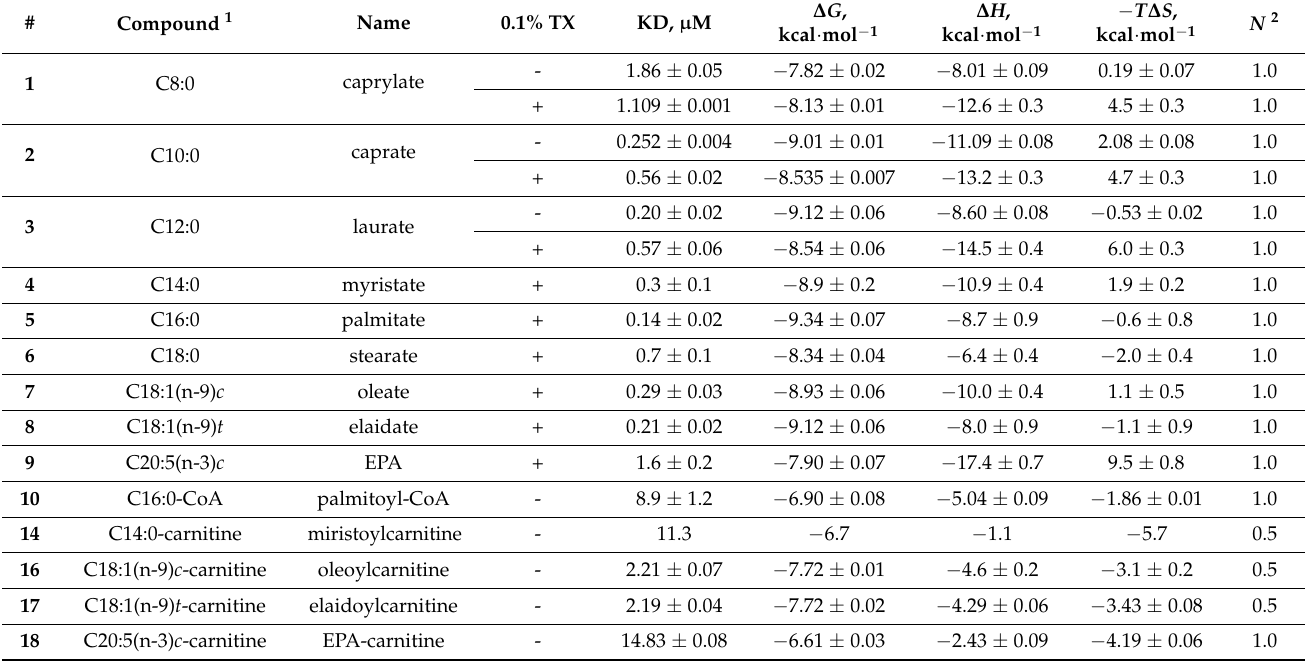
Table 1. ITC results of the heart-type fatty acid-binding protein (FABP3) interaction with fatty acids (FAs) and acylcarnitines (ACs) in 20 mM K 2 HPO 4 /KH 2 PO 4 , 50 mM KCl buffer pH 7.6 (KPi) at 25 ◦